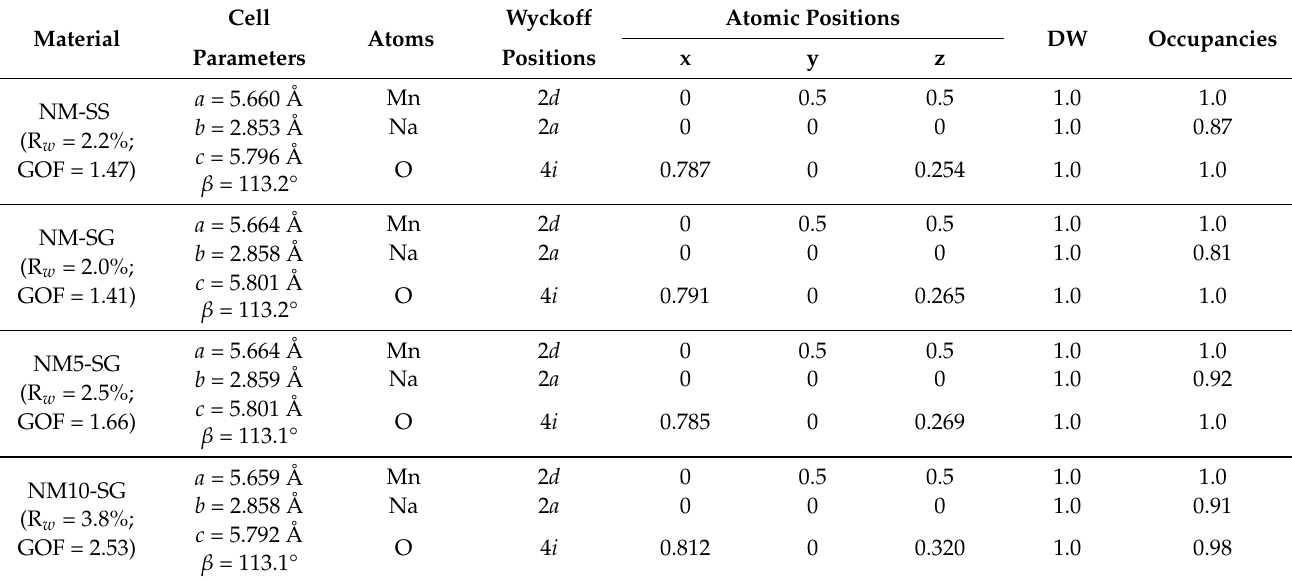
Table 3. Crystal structure parameters refined by Rietveld optimization for the four samples.